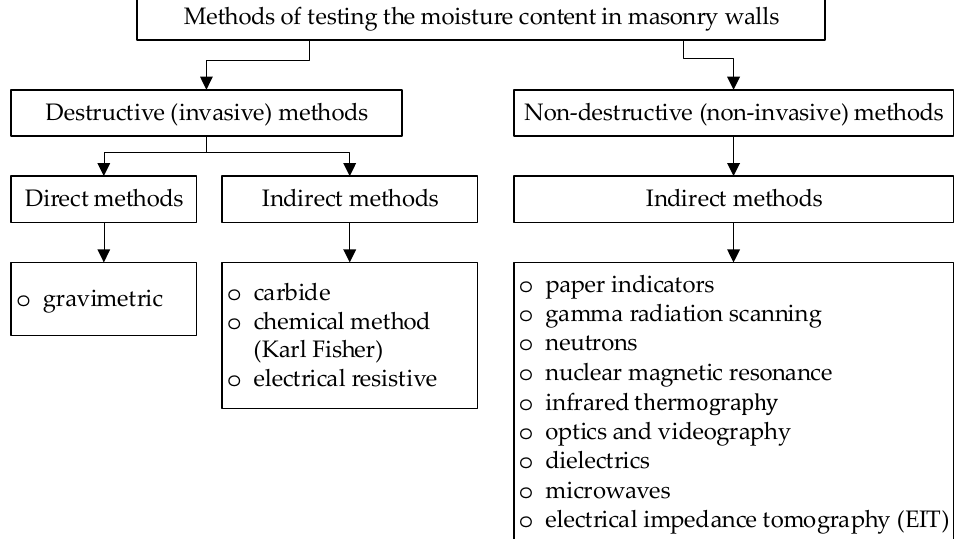
Figure 1. Classification of methods for measuring humidity inside walls [1].